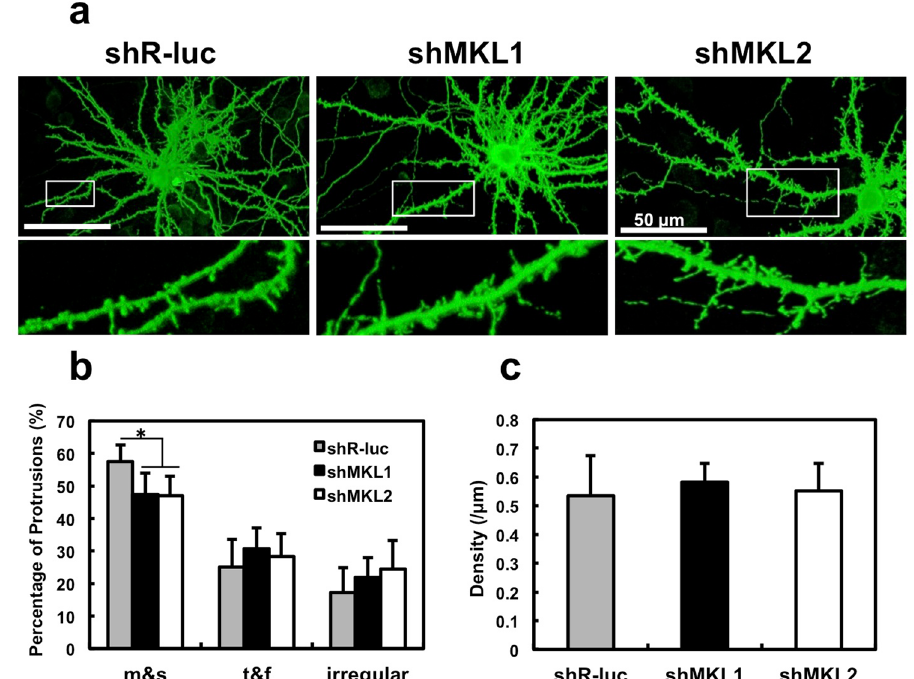
Figure 5. Effect of MKL1 or MKL2 knock-down on dendritic spine morphology and density in cortical neurons. ( a ) Spine morphology of cortical neurons transfected with pEGFP-C1 (1 μ g/well) and shR-luc, sh MKL1 , or sh MKL2 (1 μ g/well). Transfection was performed at 16 days in culture. Neurons (21 days in culture)